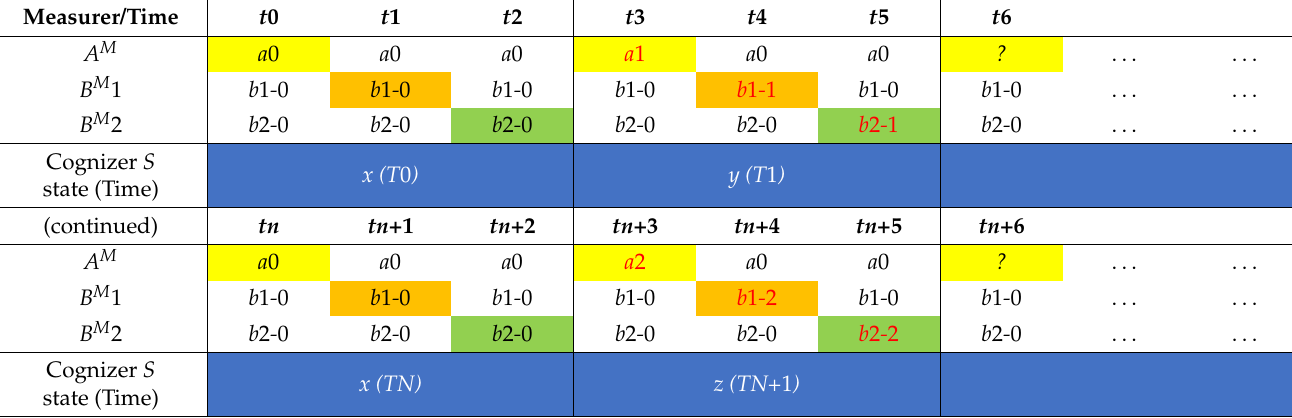
Table 2. A focal cognizer S is composed of three measurer cognizers, A M , B M 1, and B M 2, representing a sensor, a signal transducer, and an effector of a living system, respectively. In addition, a 0, b 1 - 0, and b 2 - 0 are baseline states of measurers A M , B M 1, and B M 2, respectively. One-to-many changes are highlighted with red symbols. The measurers change their states on a fine-grained timescale, t0, t1, t2, . . . , tn, tn+1, tn+2. The cognizer changes its states on a coarse-grained timescale, T0, T1, . . . , T N , T N